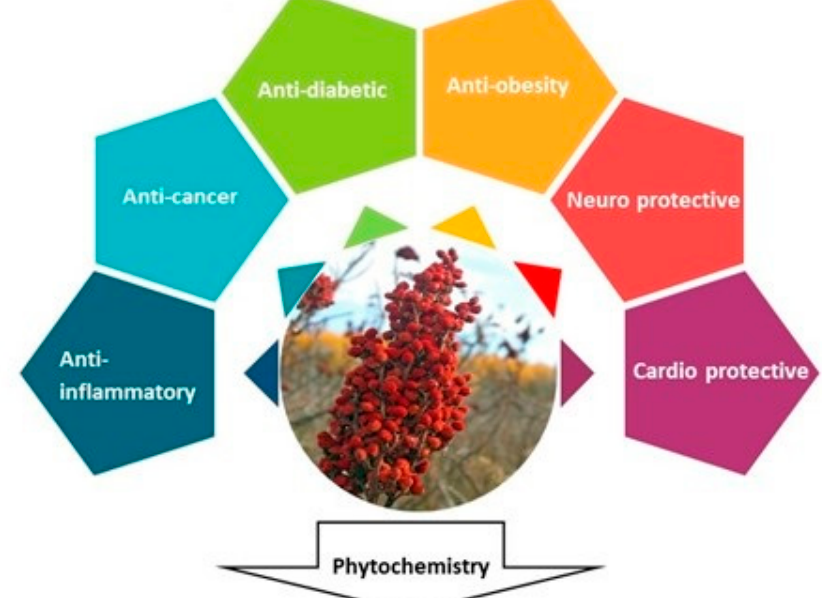
Figure 6. A graphical illustration of the health-promoting activities attributed to the Rhus coriaria fruit. The artwork also reports main bioactive compounds.